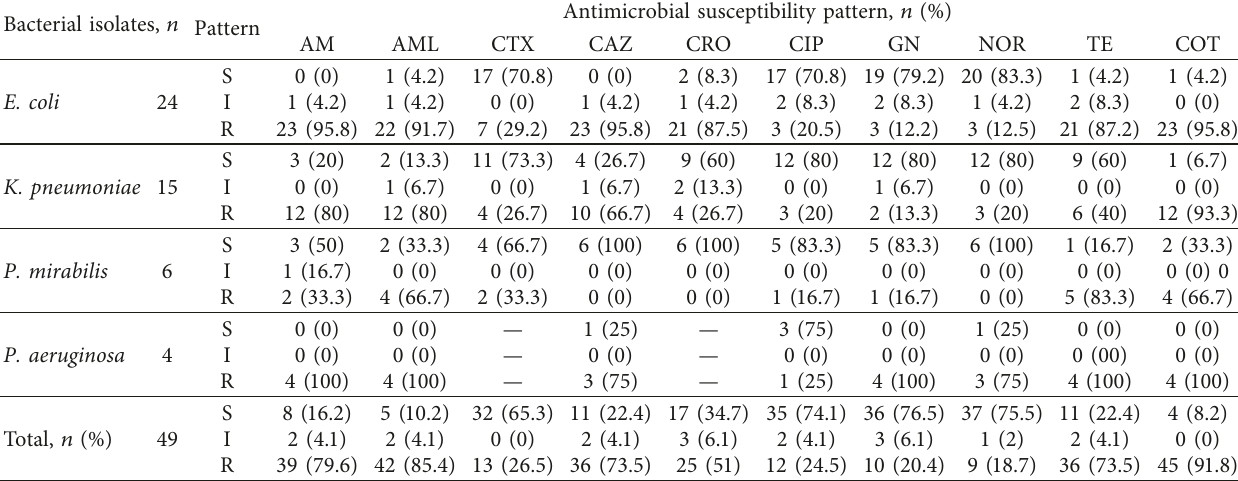
Table 4: Antimicrobial susceptibility pattern of Gram-negative bacterial isolates among HIV-positive patients at Hiwot Fana Specialized University Hospital, Eastern Ethiopia, 2016.